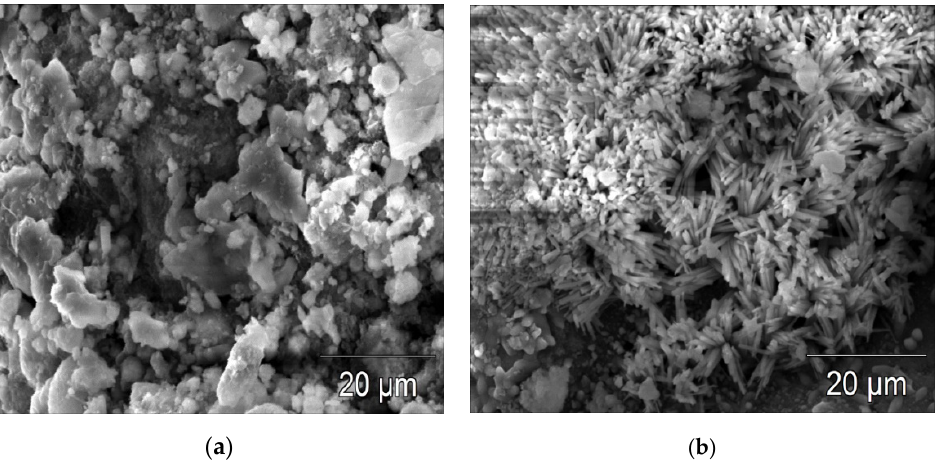
Figure 13. ( a ) SEM image of the 2H0 sample after seawater attack; ( b ) SEM image of the 2H6 sample after seawater attack.